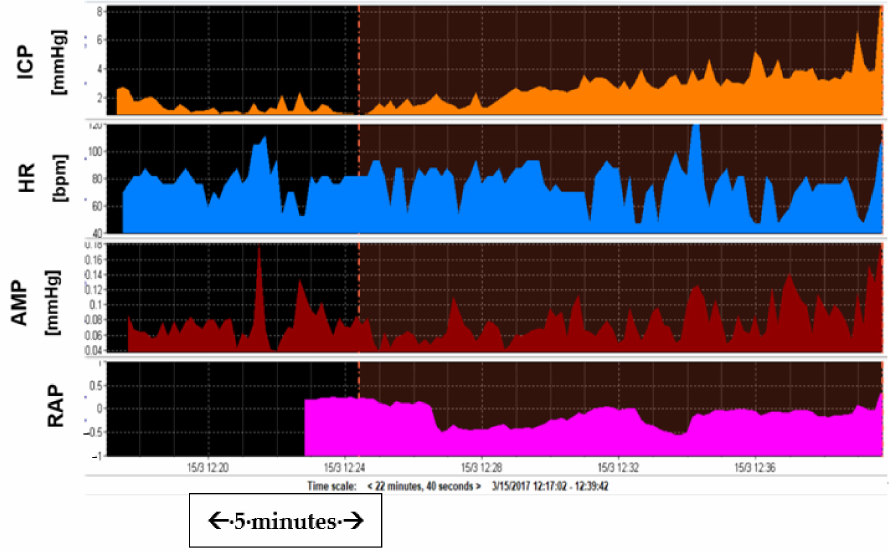
Figure 4. Example of CSF dynamics in cerebral atrophy. Picture of CSF dynamics identical to the decompressed patients: Low Rout (ICP increased from a baseline of 1.3 mmHg to 3.6 mmHg) with very low AMP at baseline (0.08), barely reacting to infusion (AMP plateau 0.09 mmHg). RAP (running correlation coefficient between changes in 10 sec averaged ICP and AMP over 5 min